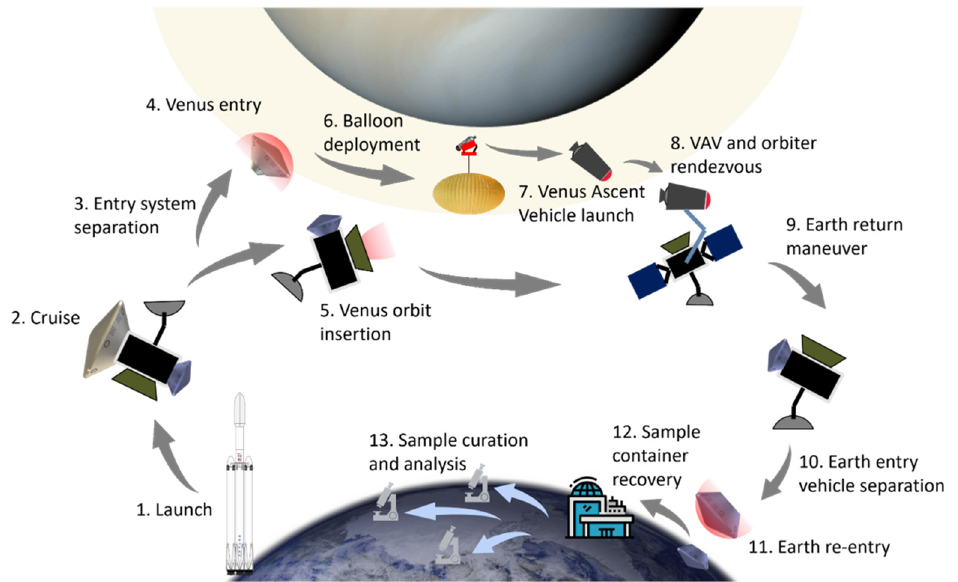
Figure 3. Schematic mission architecture for atmospheric sample return from Venus. VAV stands for Venus ascent vehicle.